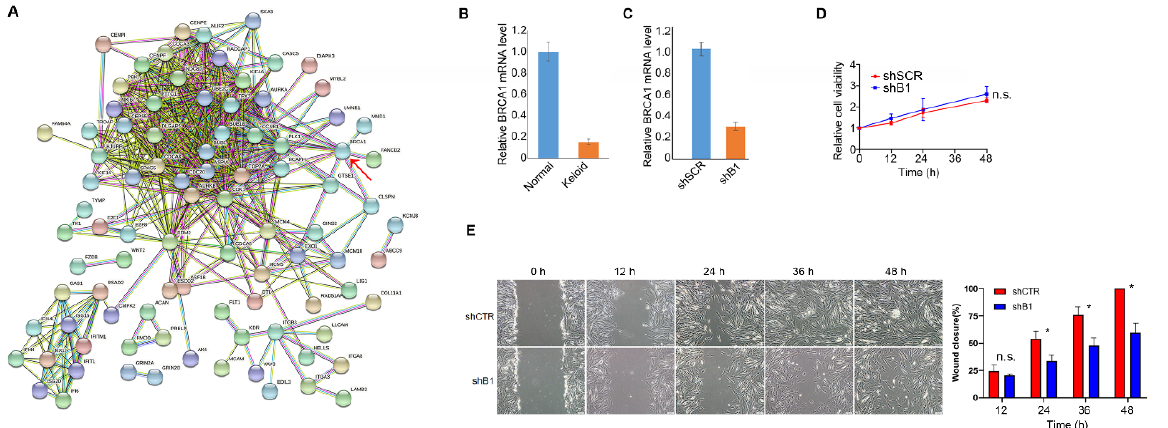
Figure 3. Suppressed BRCA1 expression is a potential pathogenic factor in keloid. ( A ) Protein– protein interaction (PPI) network of DEGs based on STRING database. More lines between two genes indicates more reliable interactions between them, and line color represents evidence type for their interaction. BRCA1 as a hub gene, i.e., highly connected in the network, is highlighted by a red arrow. ( B ) Validation of down-regulation of BRCA1 in keloid DF compared with normal DF, as well as in shBRCA1 and shSCR DF samples by RT-PCR. ( C ) Validation of the suppression of BRCA1 by small hairpin RNA (shRNA) by RT-PCR in normal DF. ( D ) Relative cell viability of normal DF that transfected with shRNA for BRCA1 (shB1) or control (shSCR) quantified by CCK-8 method. ( E ) Wound-healing ability of normal DF that transfected with shB1 or shSCR and quantified by scratch test. The left panel shows the representative DF wound-healing examples and the right panel illustrating the wound closure percent of shB1 and shSCR DF at different time points. Error bars represent the mean ± standard deviation (SD) of three independent experiments. n.s., not significant; * p value < 0.05.